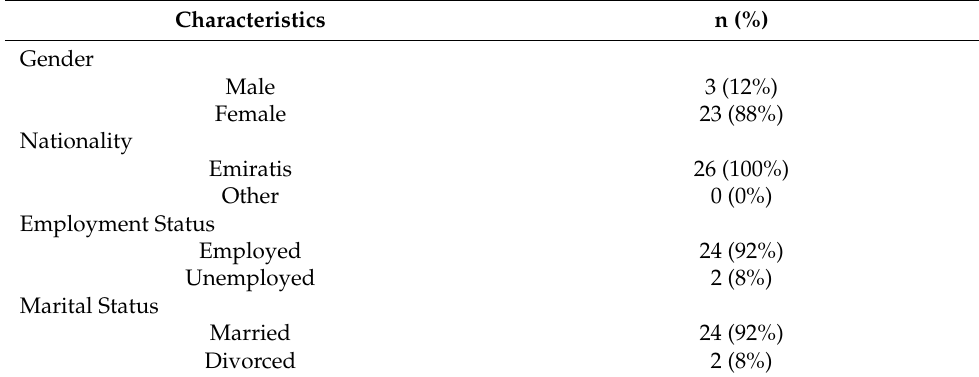
Table 1. Demographic information of interviewed